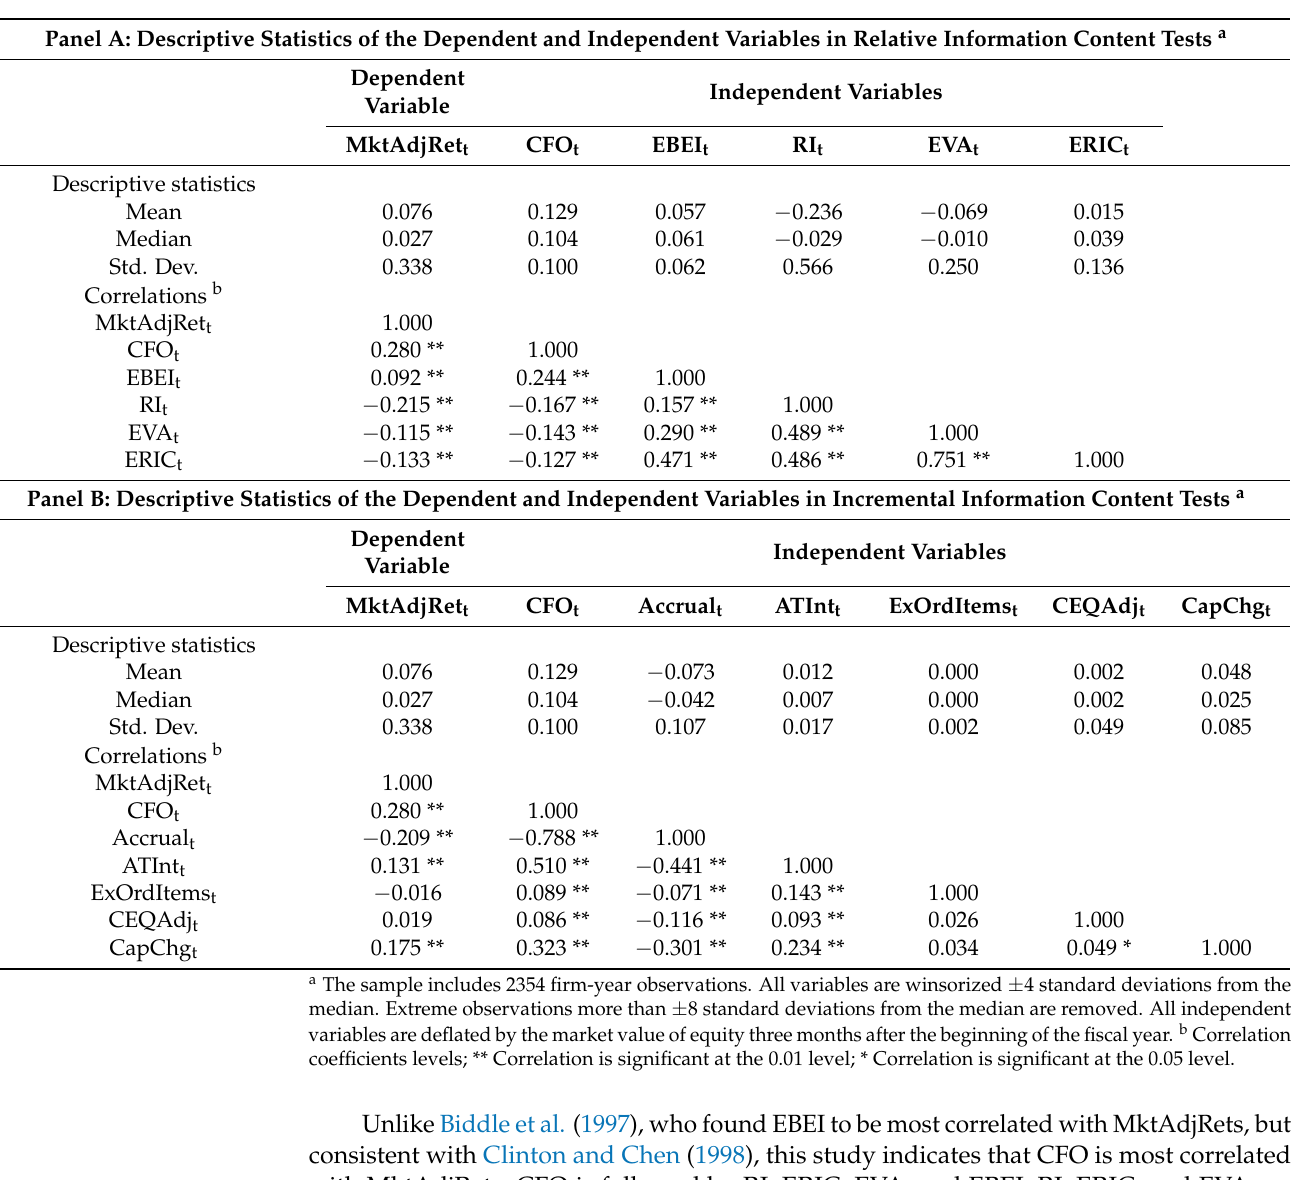
Table 1. Descriptive statistics for pooled